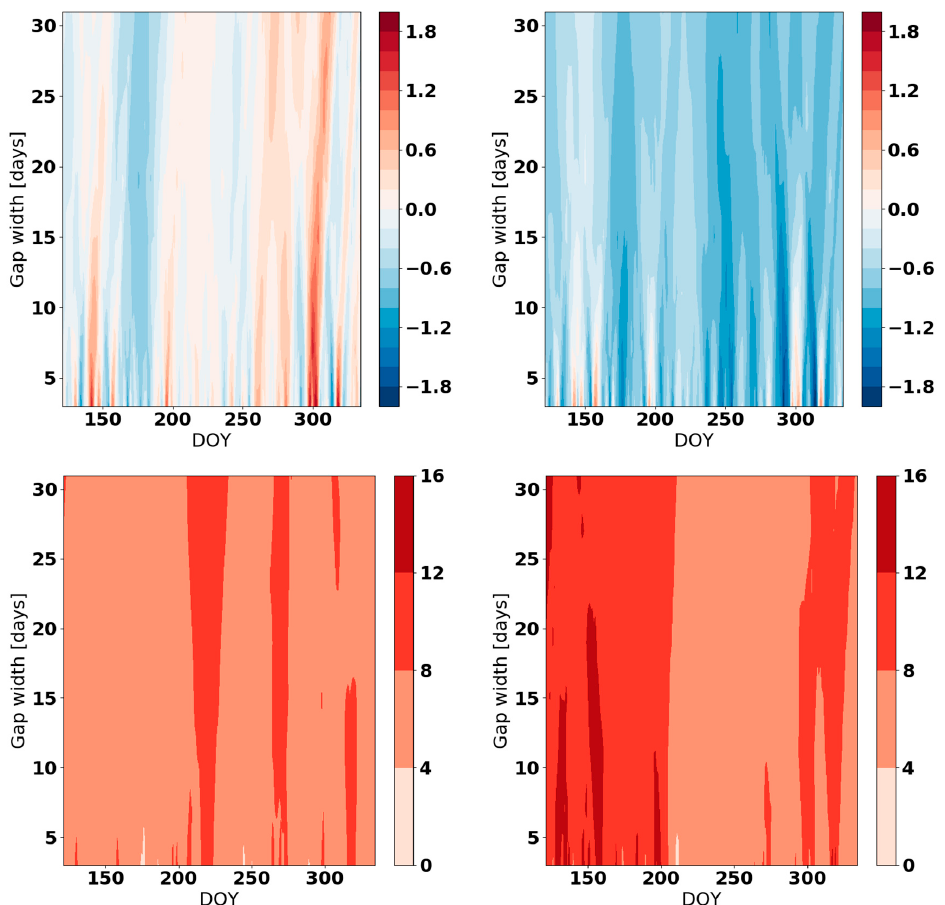
Figure A3. B DEB ( top , left panel ), B ERA5 ( top , right panel ), U(B) DEB ( bottom , left panel ), and U(B) ERA5 ( bottom , right panel ) calculated using data for DOY 121–334 2017 in Bahariya.